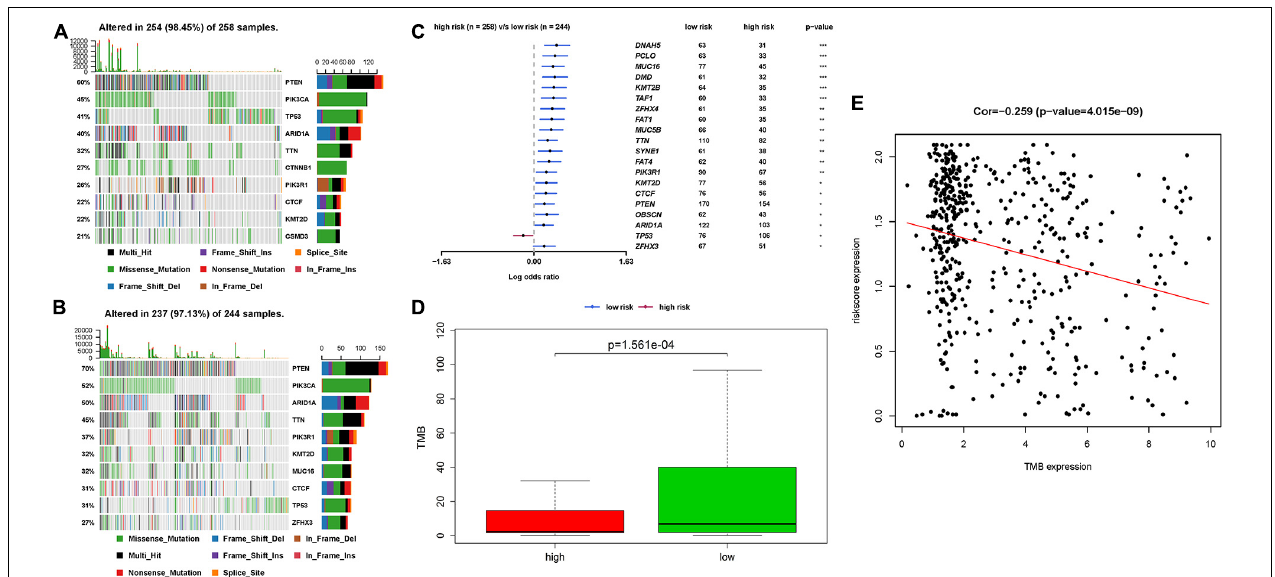
FIGURE 9 | The mutation profile and TMB among high-risk and low-risk group. (A,B) The top 10 mutated genes in high-risk and low-risk group. (C) The most frequently mutated genes in high-risk and low-risk group. (D) The TMB in high-risk and low-risk group. (E) The relationship between TMB and IRPS. TMB: tumor mutational burden.